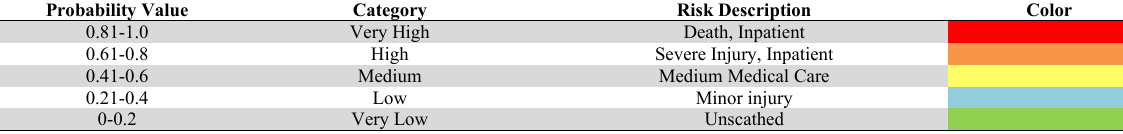
Analysis of Scale and Level of Risk (Hosseinnia et al., 2018)